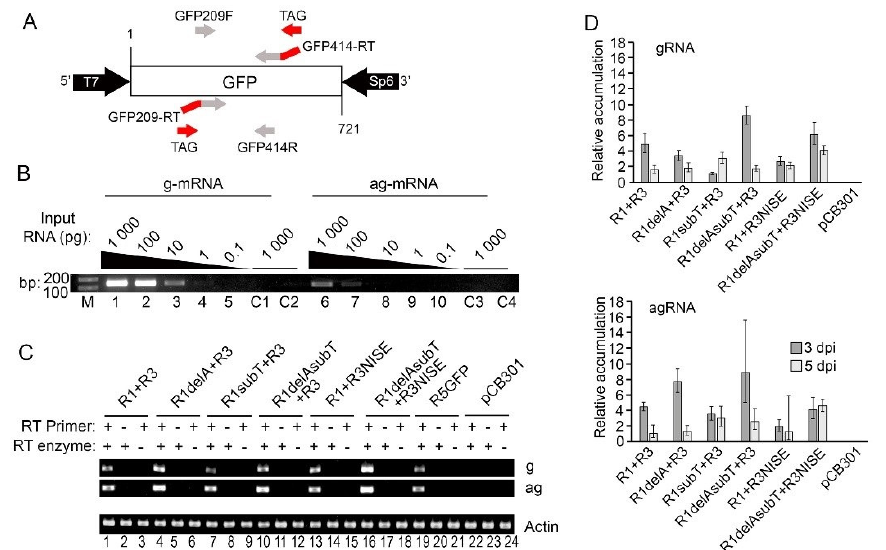
Figure 4. Strand-specific RT-PCR of a non-viral template to observe replication. ( A ) Diagram repre- senting the pGEMT-eGFP construction and primers (arrows) for strand-specific RT-PCR amplification. Reverse transcription used GFP209-RT and GFP414-RT primers, each having a 20 nt tag sequence at the 5 (cid:48) end (red). ( B ) Endpoint RT-PCR of GFP transcripts detecting gRNA (lanes 1–5, C1 and C4) and agRNA (lanes 6–10, C2 and C3). First-strand synthesis using serial dilutions (1000 to 0.1 pg) of transcripts are identified above lanes 1 to 5 and 6 to 10. C1 and C3 identify control reactions performed without the RT primer. C2 and C4 identify control reactions performed using the opposite RNA templates. All four control reactions used 1000 pg of transcripts. ( C ) Strand-specific endpoint RT-PCR detecting R5GFP RNA at 3 dpi following delivery of the wild-type and mutant RRV-GFP replicons. The control treatments were R5GFP +p19 only or the empty pB301 vector (lanes 19 to 24). Reactions performed with (+) or without ( − ) the primer or reverse transcriptase enzyme for first-strand synthesis are featured above the lanes. The bottom gel shows actin as internal controls. ( D ) RT-qPCR detecting GFP RNA in N. benthamiana leaves 3 and 5 dpi. The gRNA and agRNA levels are presented as relative to R5GFP +p19 using the ddCt method. The graph represents five experimental repetitions. The error bars highlight the ranges calculated from the mean Ct with 95% confidence